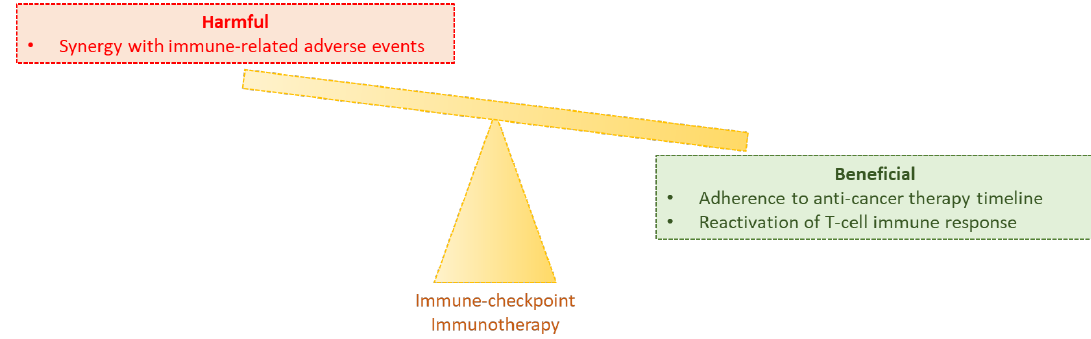
Figure 1. Balance between harmful and beneficial effects of immune-checkpoint immunotherapy in cancer patients during COVID-19 pandemic. If on one side immune checkpoint inhibitors (ICIs) have shown rare immune-related adverse events, in particular interstitial pneumonitis (red box); on the other side cancer patients that do not postpone the immunotherapy, continue to adhere to the program therefore having more chance of positive outcomes. Moreover, they reactivate the immunocompetence, in particular the T-cell mediated immunity, not only towards cancer cells, but also against viral infection (green box).